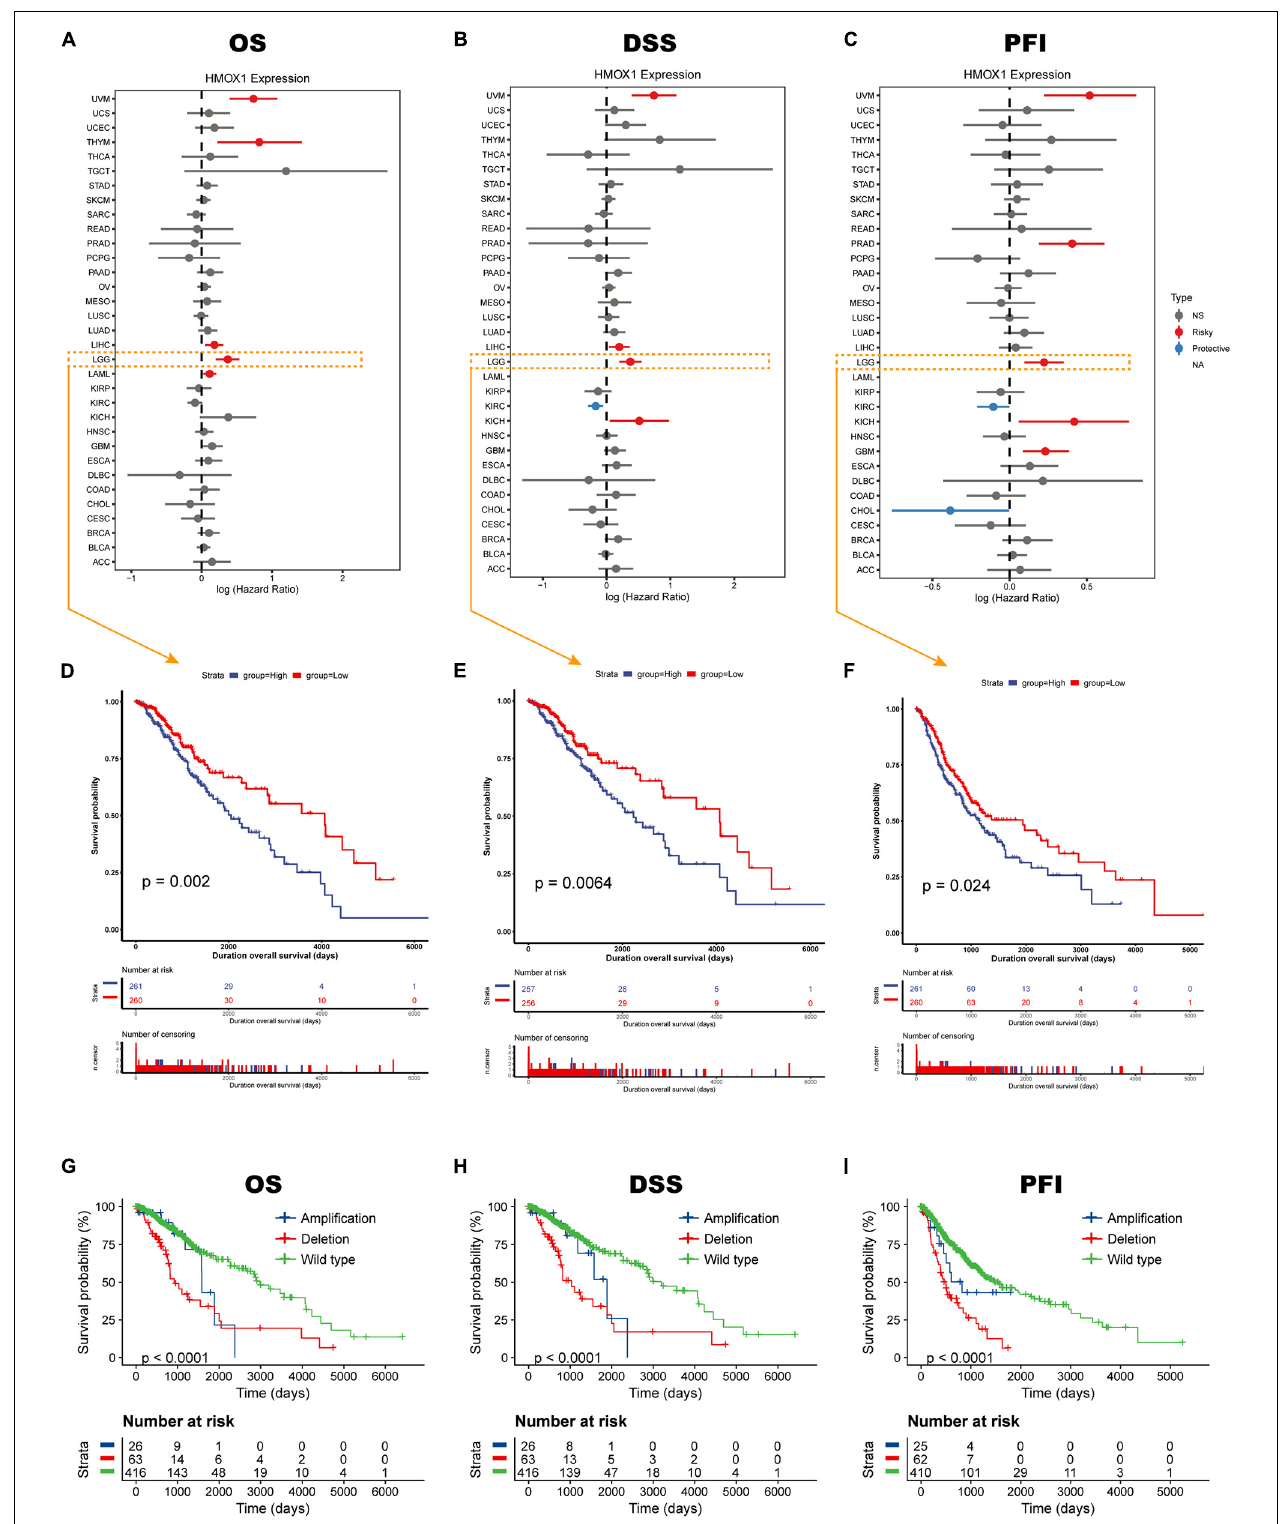
FIGURE 2 | Survival profiles of HMOX1 in cancers. Relationships between HMOX1 expression and (A) OS, (B) DSS, (C) PFI across 33 cancer types in TCGA database. (D–F) Kaplan-Meier survival curves based on HMOX1 expression. (G–I) Kaplan-Meier survival curves based on HMOX1 CNV status.